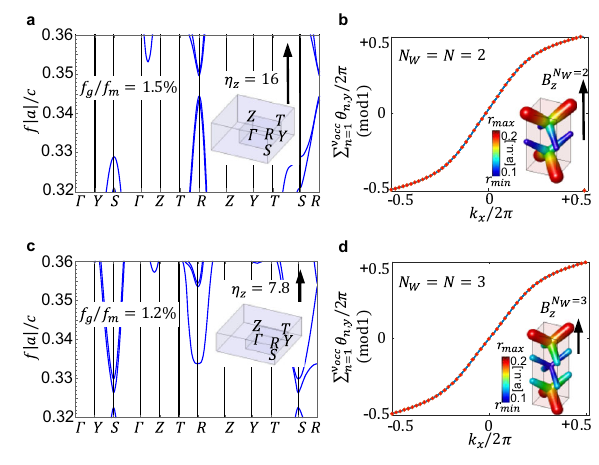
Fig. 2 3D CI in a reduced magnetization environment. Uniaxial supercells (1, 1, N ) with modulation parameter r m = r 0 /20 and WLs on selected planes for k z /2 π = 0.3. a , b 3D CI with C z = 1 at large magnetization η N W ¼ 2 ¼ 16, corresponding to the maximum Weyl dipole separation and band-gap. c , d 3D CI in a reduced magnetic environment η N W ¼ 3 ¼ 7 : 8. The band-gap only suffers a moderate contraction, yet the Chern vector and the topological properties are preserved. Source data are provided as a Source Data fi